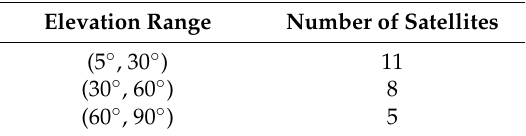
Table 7. Number of satellites in different elevation ranges when the number of visible satellites at the Linzhi airport is minimized.